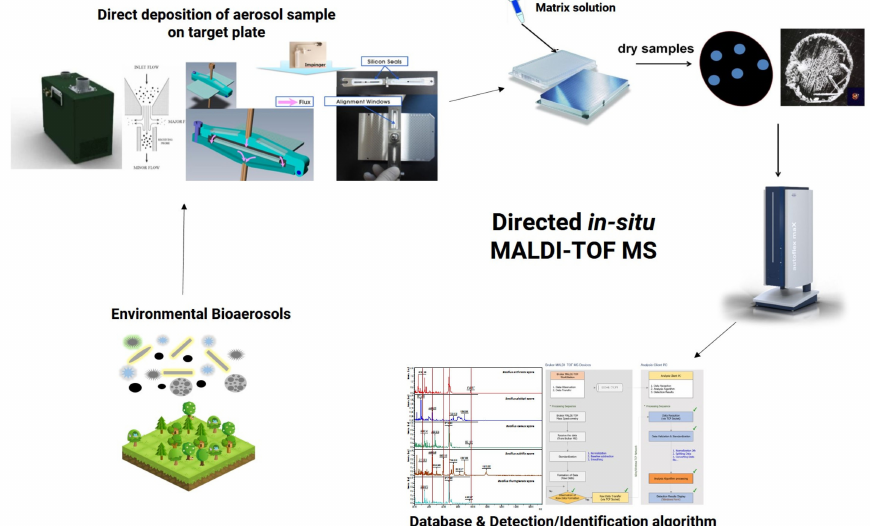
Figure 2. Schematic representation of a direct in situ MALDI TOF MS system for the rapid detection of bioaerosol particles [49,50]. The detection capability of aerosolized BWAs with sizes of 2–10 µ m was confirmed by aerosol collection system, which can be most effectively accumulated on respiratory organs. Reprinted with permission from [49]. The Korean Chemical